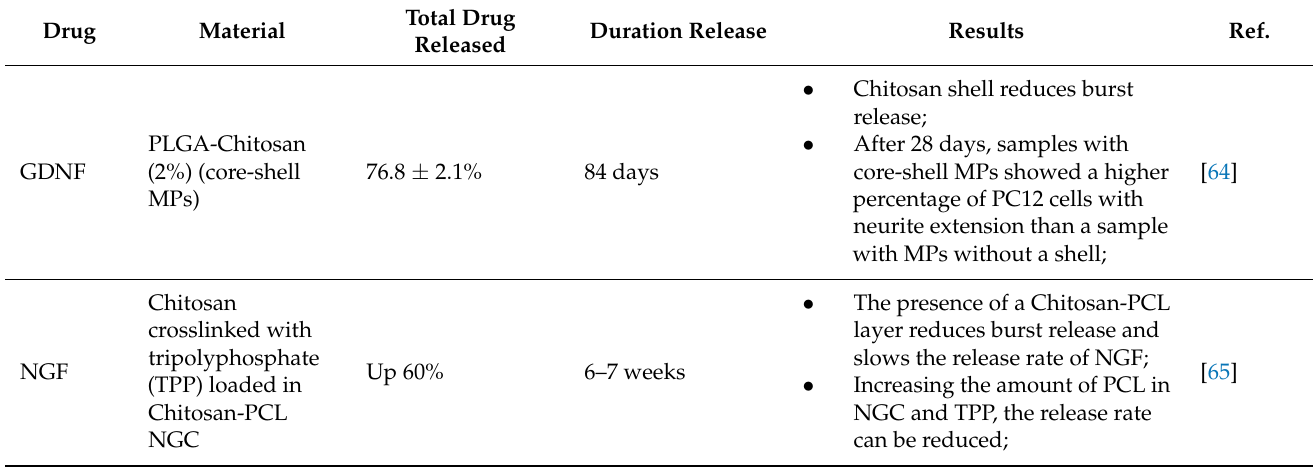
Table 2. Schematic list of microparticle studies to enhance nerve